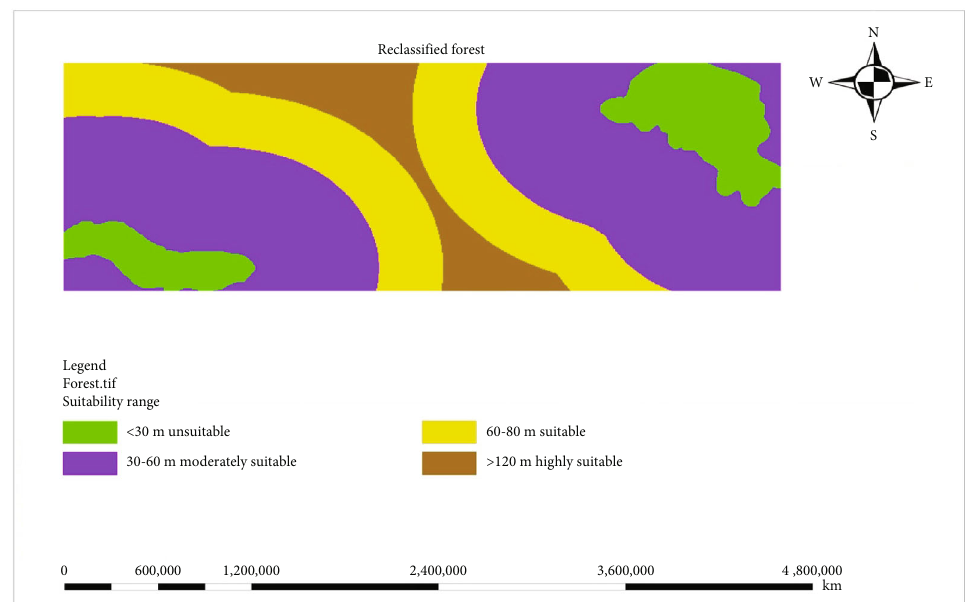
Figure 9: Suitable forest distance for solar PV.